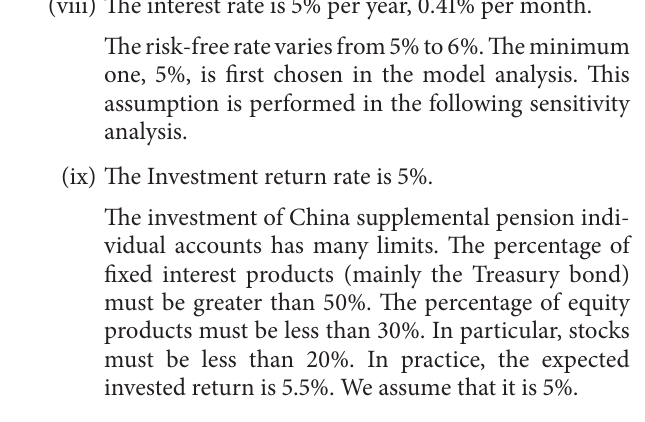
Table 1: Sample employees information.